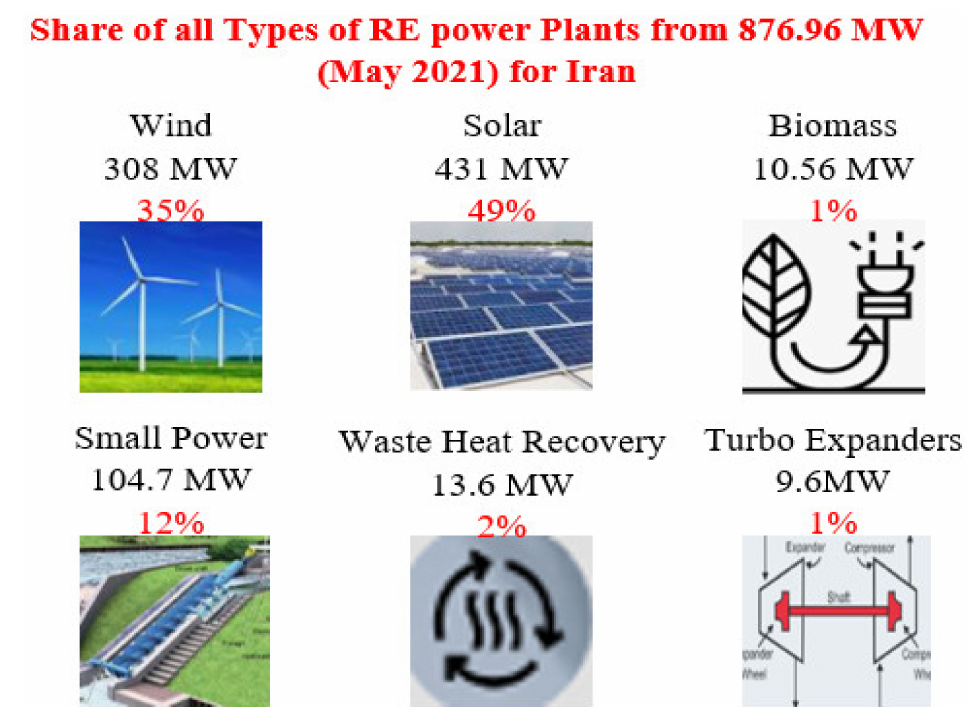
Figure 10. Share of all types of RE power plants